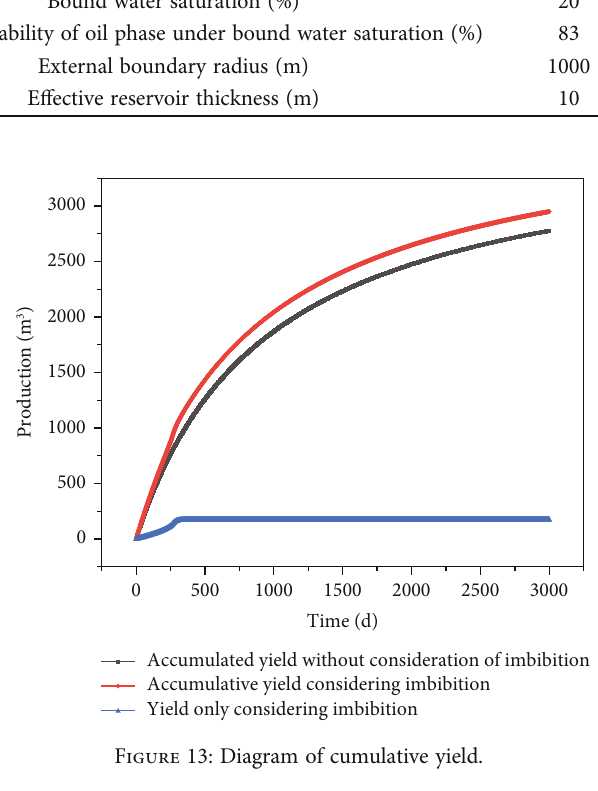
Figure 13: Diagram of cumulative